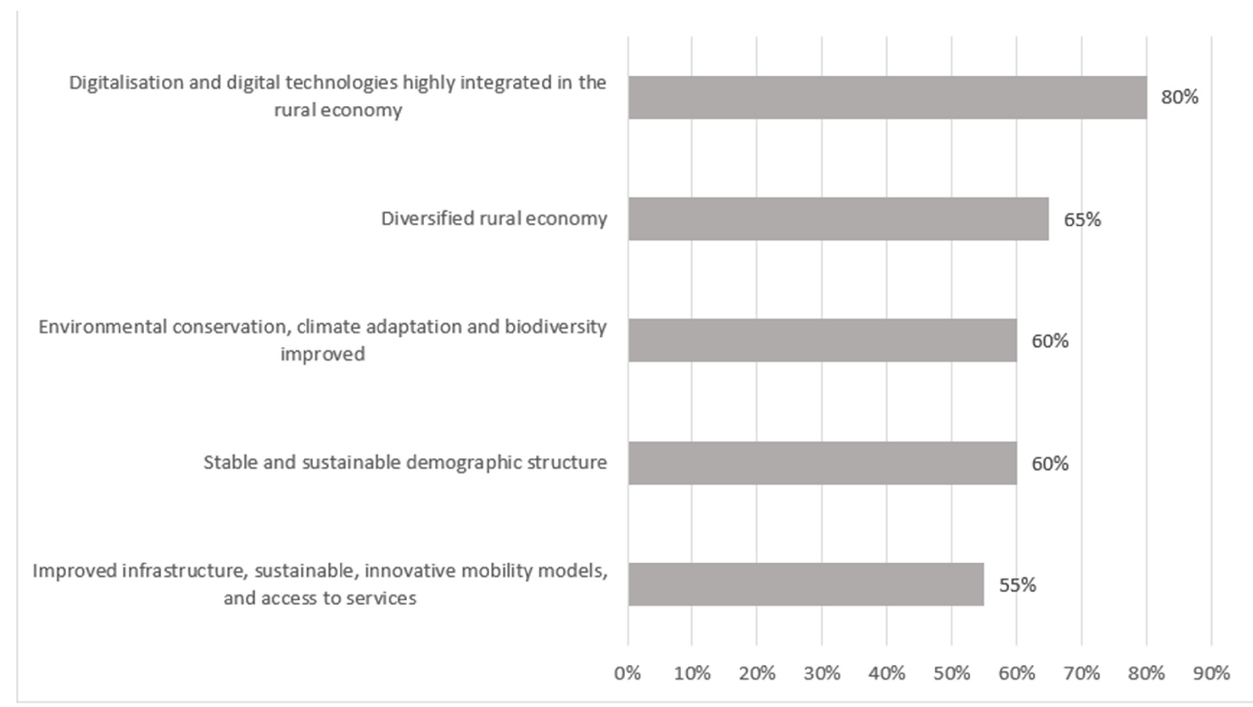
Figure 2. Key elements of the desirable long-term vision for rural areas in the EU according to the SHERPA MAPs. Source: Own processing based on data presented in